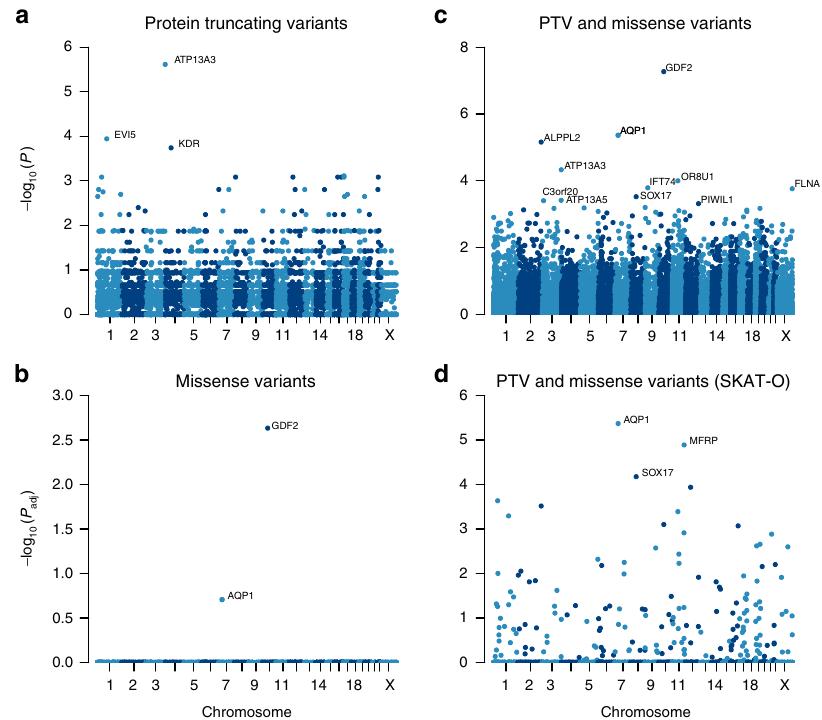
Fig. 3 Manhattan plots of the rare variant analyses, having excluded cases carrying rare variants in previously established PAH genes. Filtered variants were grouped per gene. We tested for an excess of variants in PAH cases within genes using Fisher ’ s exact test. The negative decadic logarithm of unadjusted or adjusted P -values are plotted against the chromosomal location of each gene. a Burden test of rare PTVs. b Burden test of rare deleterious missense variants. c Burden test combining rare PTVs and likely deleterious missense variants. d SKAT-O test of rare PTVs and missense